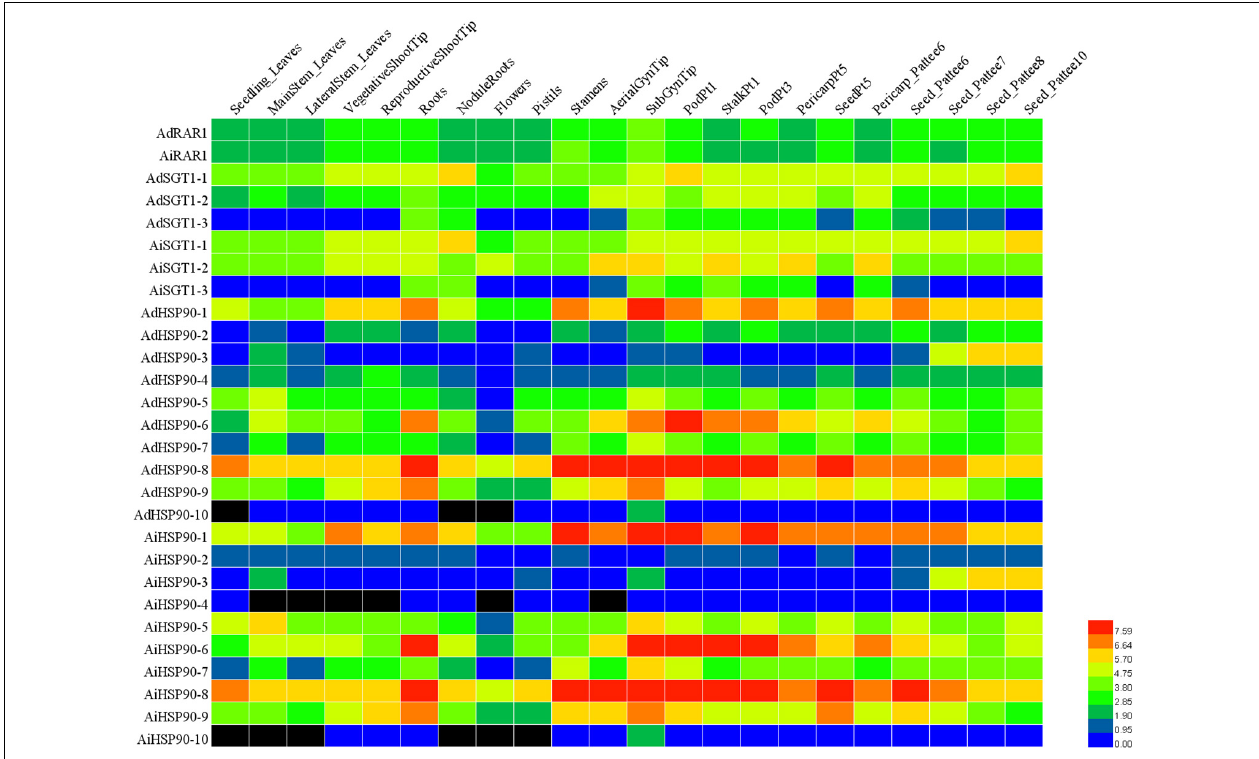
FIGURE 7 | Expression profiling of HRS genes in 22 different tissues of A. duranensis and A. ipaensis . The FPKM data of each gene were retrieved from Clevenger et al. (2016), log2-transformed and displayed in the form of a heatmap by HemI. The color scale in the lower right indicates relative expression level: green represents a low level, and red indicates a high level. The 22 different tissues are listed at the top of the heat map. The HRS genes are listed on the left of the heatmap.